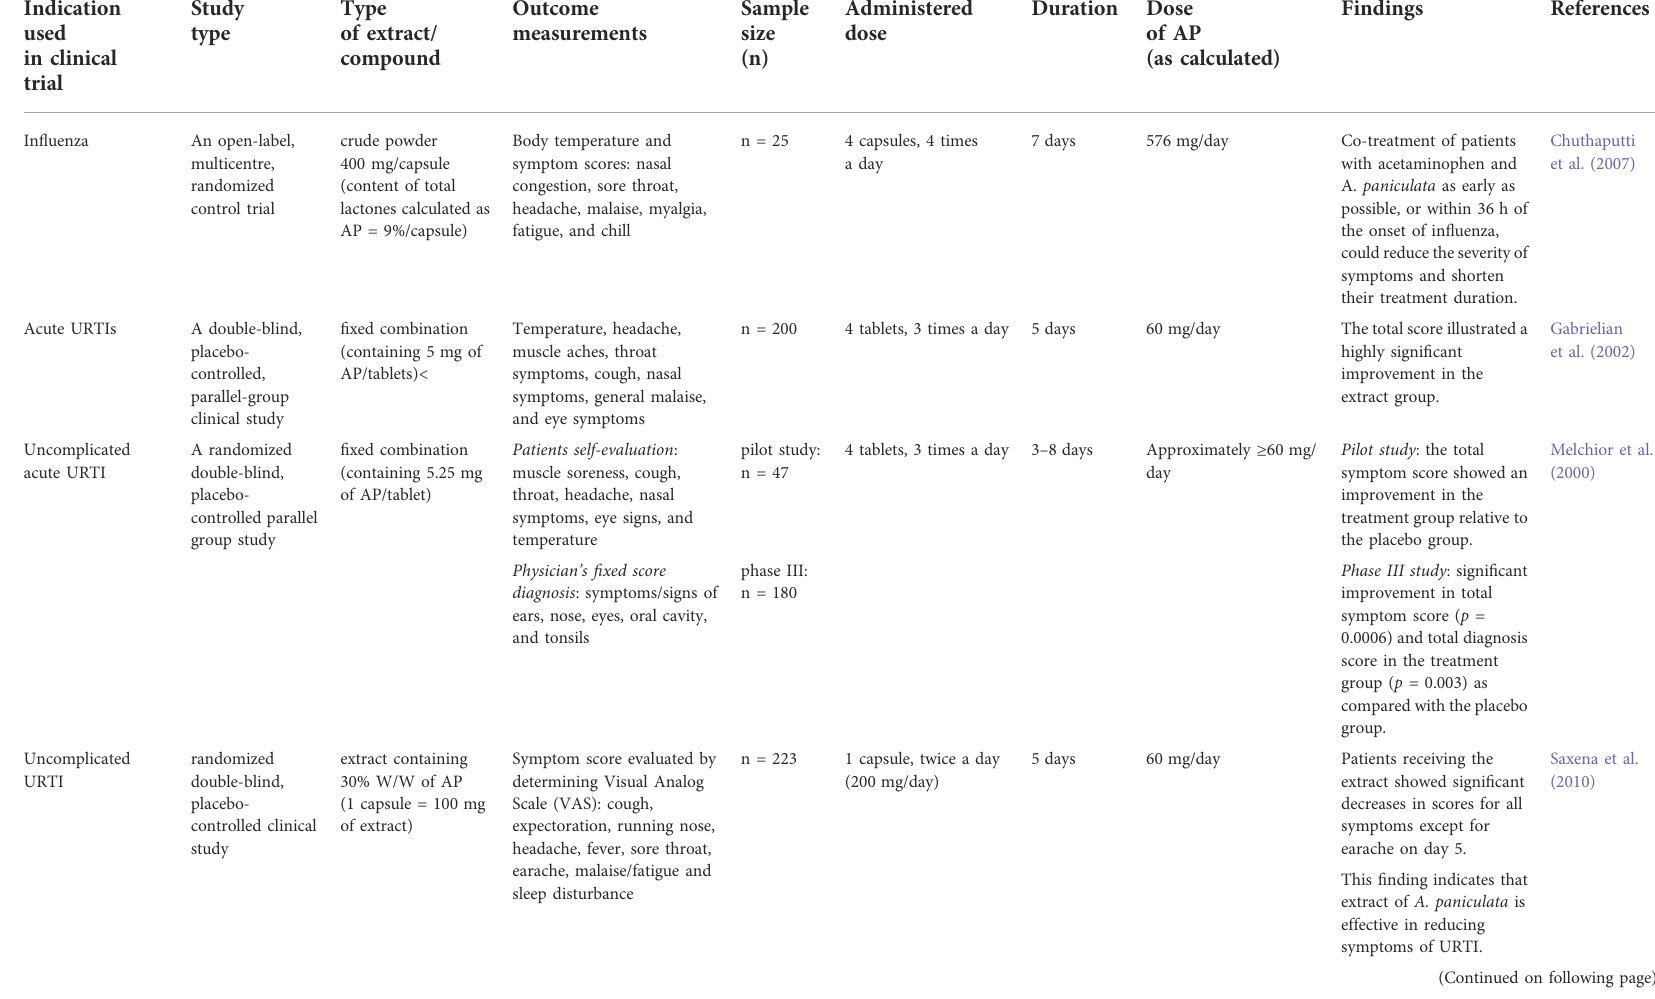
TABLE 4 Clinical studies of A. paniculata extract in uncomplicated upper respiratory tract infections (URTIs) and other viral infectious